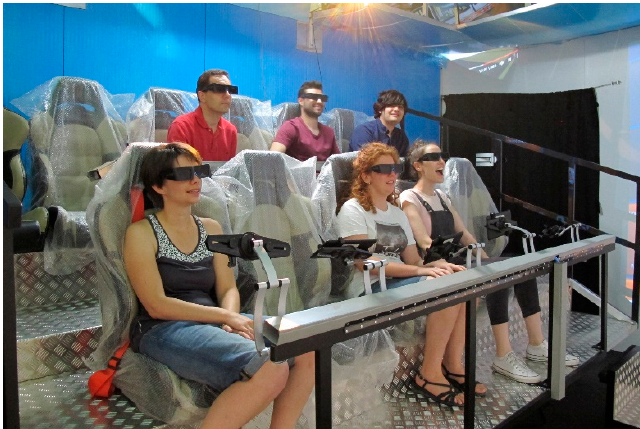
Figure 9. Image of some of the research staff testing ROMOT.